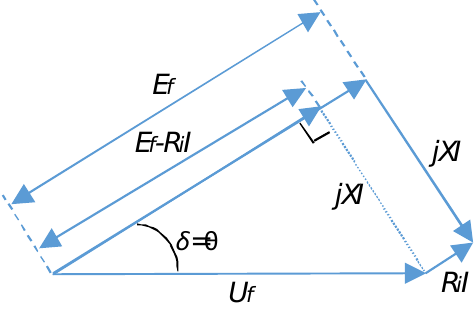
Figure 2. Phasor diagram for a non-salient synchronous generator with CTA